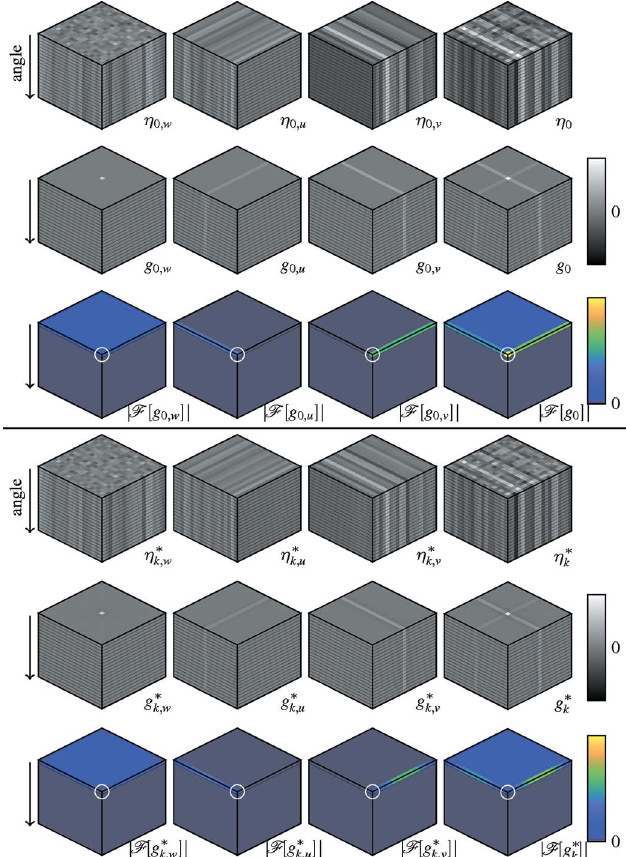
= 6, & = 5, and & = 0 ; w 0 ; u 0 ; v . For all k ; p